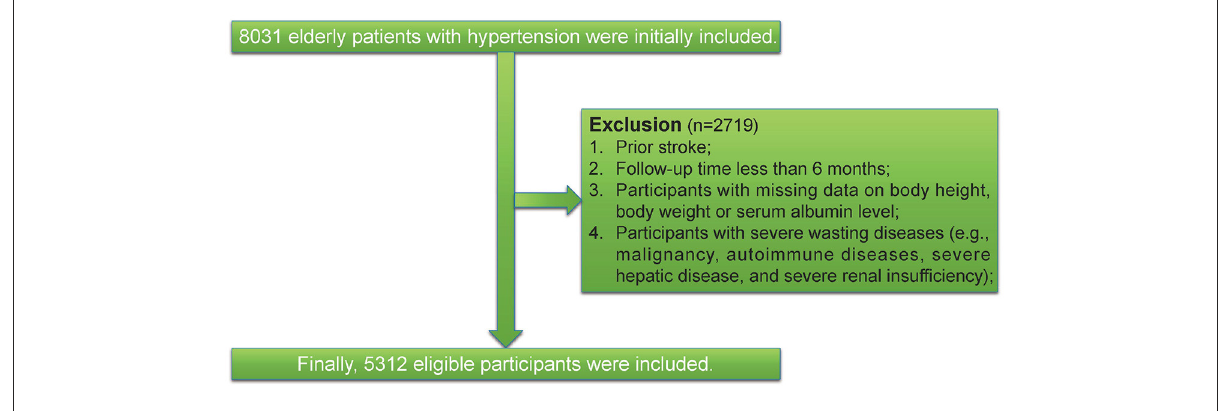
FIGURE1 Study flowchart.